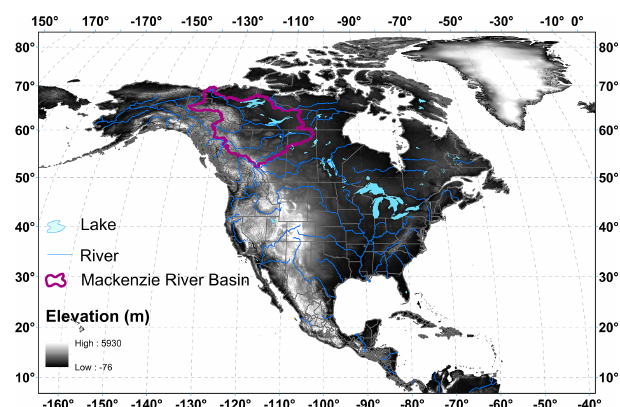
Figure 1. Location of the Mackenzie River Basin in North Amer- ica. Digital elevation data come from GTOPO30 – 30arcsec digi- tal elevation data for the globe (https://www.arcgis.com/home/item. html?id=5771199a57cc4c29ad9791022acd7f74; last access: Febru- ary